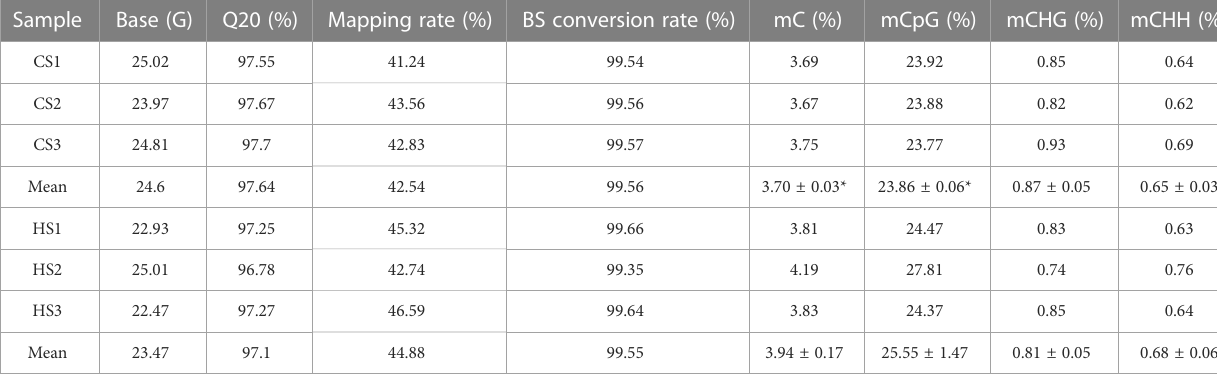
TABLE 2 Statistical data for whole genome bisul fi te